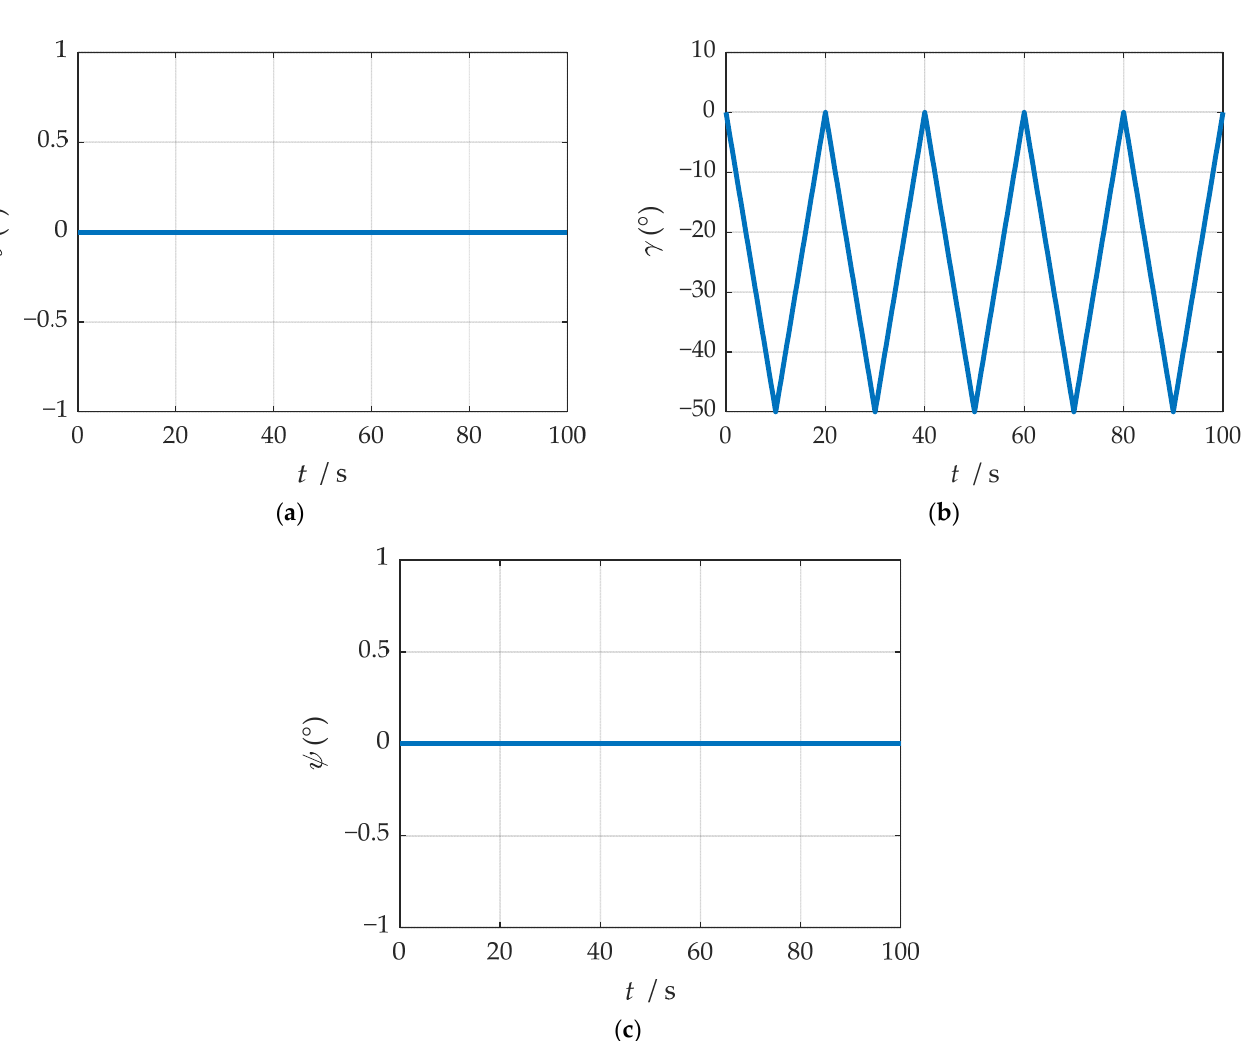
( b ) Figure 26. The navigation information of the b-frame obtained after coordinate system transformation: ( a ) angular veloc- ity information; ( b ) specific force information. As can be observed from Figure 26, after coordinate system transformation in navi- gation solution, the IMU data of compound rotation modulation was calculated to a pe- riodic signal with an estimated true value under b-frame. Additionally, the attitude solu- tion results are shown in Figure 27. Maximum errors between two rotational modulation schemes comparison are shown in Table 11.